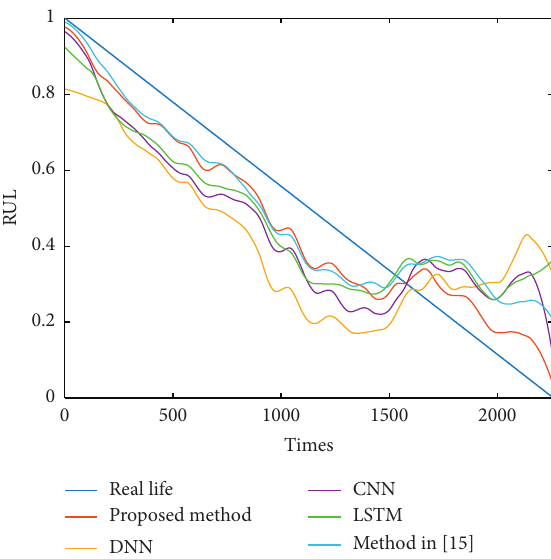
Figure 15: RUL estimation result of bearing 1_7 with different methods.